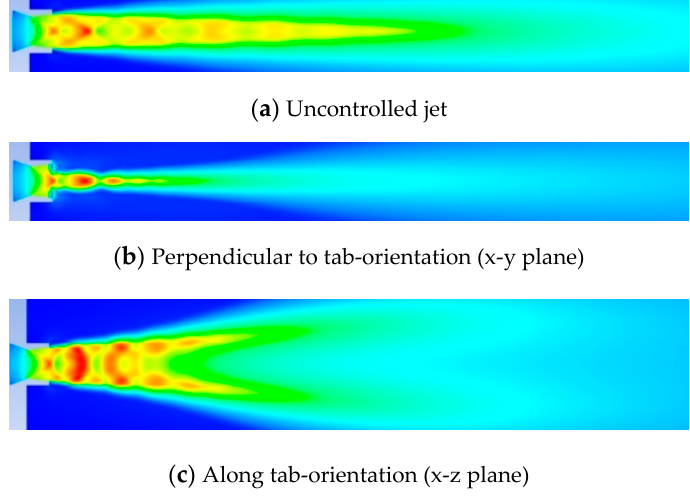
Figure 27. Mach contours of uncontrolled and controlled jets at NPR 7 (underexpansion).